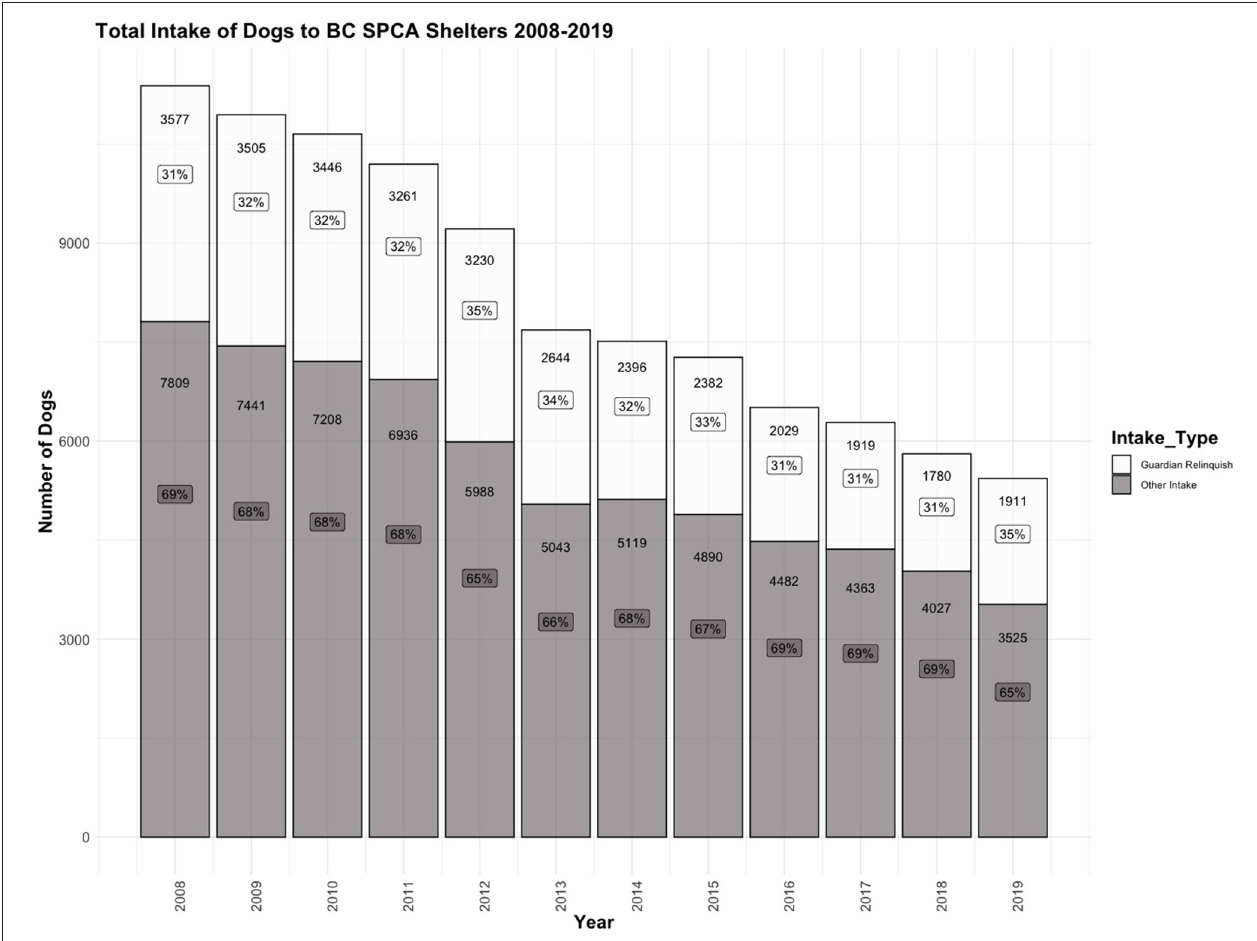
FIGURE 1 | The number of dogs admitted to the BC SPCA between 2008 and 2019. The number of dogs known to be relinquished due to guardian relinquishment is represented in white, and the number of dogs entering the shelter by other intake sources is represented in gray. The number of dogs for each intake type by year is labeled on the corresponding bars in black text, and the percentage (%) of total intake of each intake type are labeled on the corresponding bars in